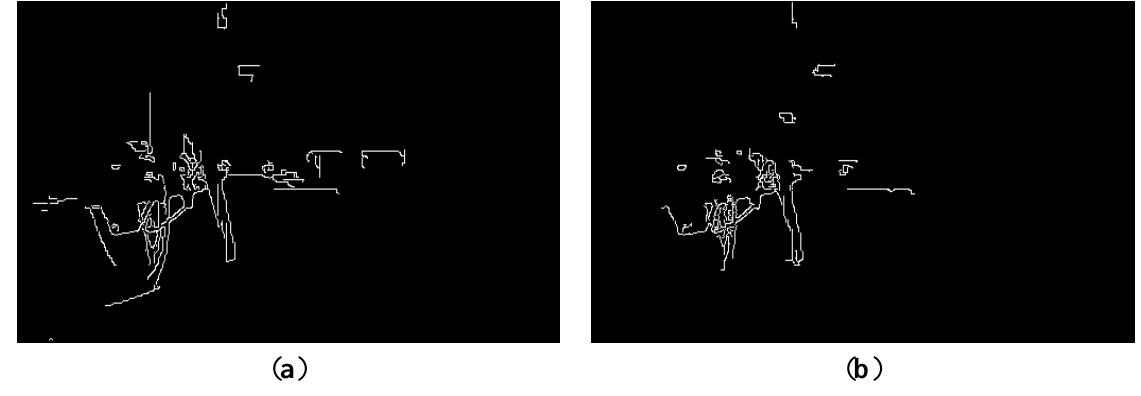
Figure 5. The two edge images obtained from the transformed images (whose contrasts are changed according to our foveation model) using the left and right images from Figure 3b: ( a ) left image; ( b ) right